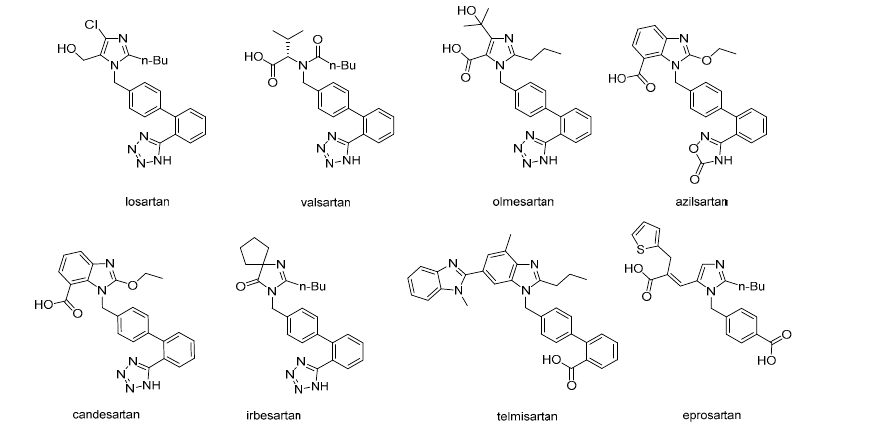
Figure 2. Structures of commercially available